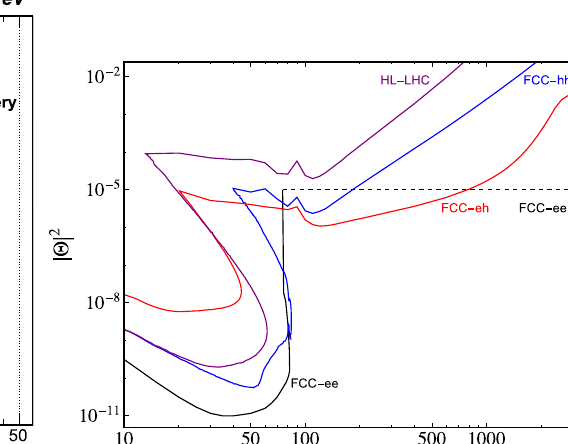
Z decays), FCC-hh (blue in W decays) and FCC-eh (in production from the incoming electron). The dashed line denotes the impact on precision measurements at the FCC-ee, it extends up to more than